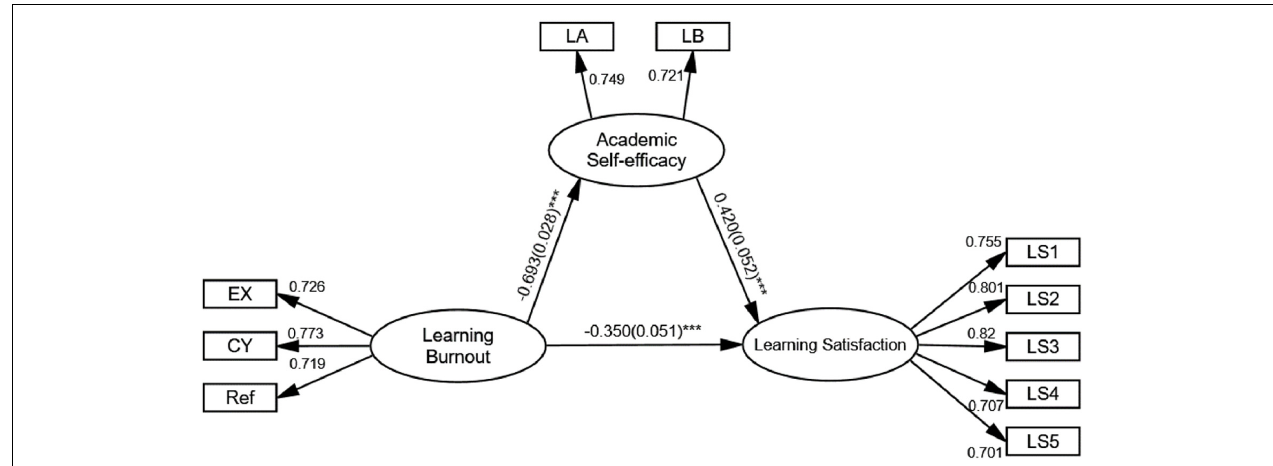
FIGURE 2 | The path model for the relationship amongst university students’ English online learning burnout, academic self-efficacy, and learning satisfaction. EX, exhaustion; CY, cynicism; Ref, reduced efficacy; LA, learning ability; LB, learning behaviour; LS, learning satisfaction.